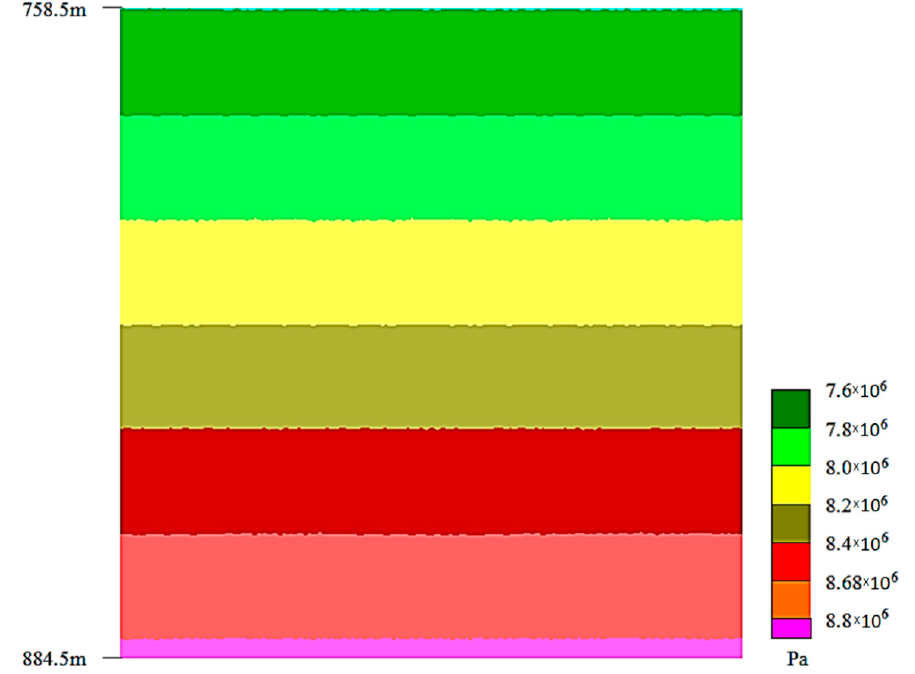
Figure 8. Map of the initial vertical stress gradient in the rock mass model.